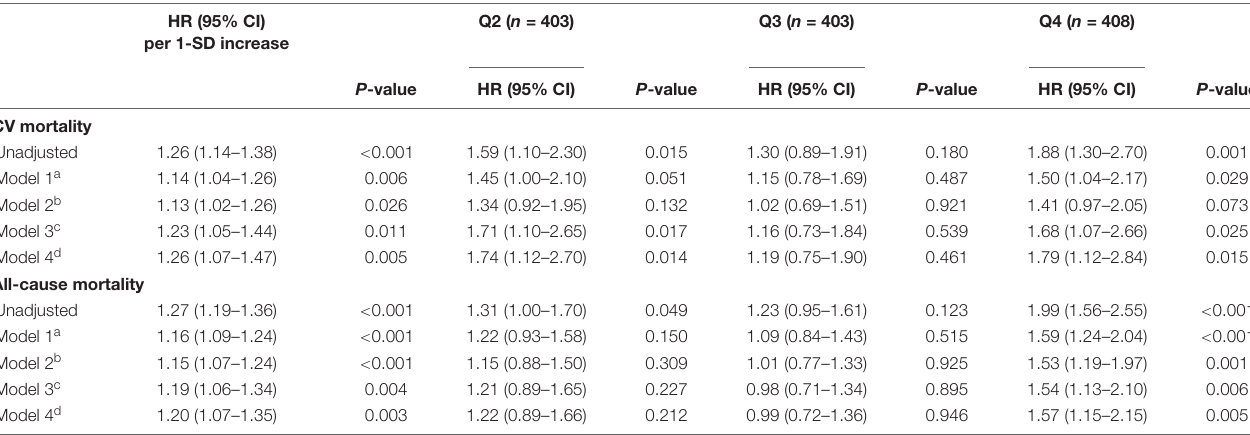
TABLE 2 | Association of apo B/apo A1 ratio with CV and all-cause